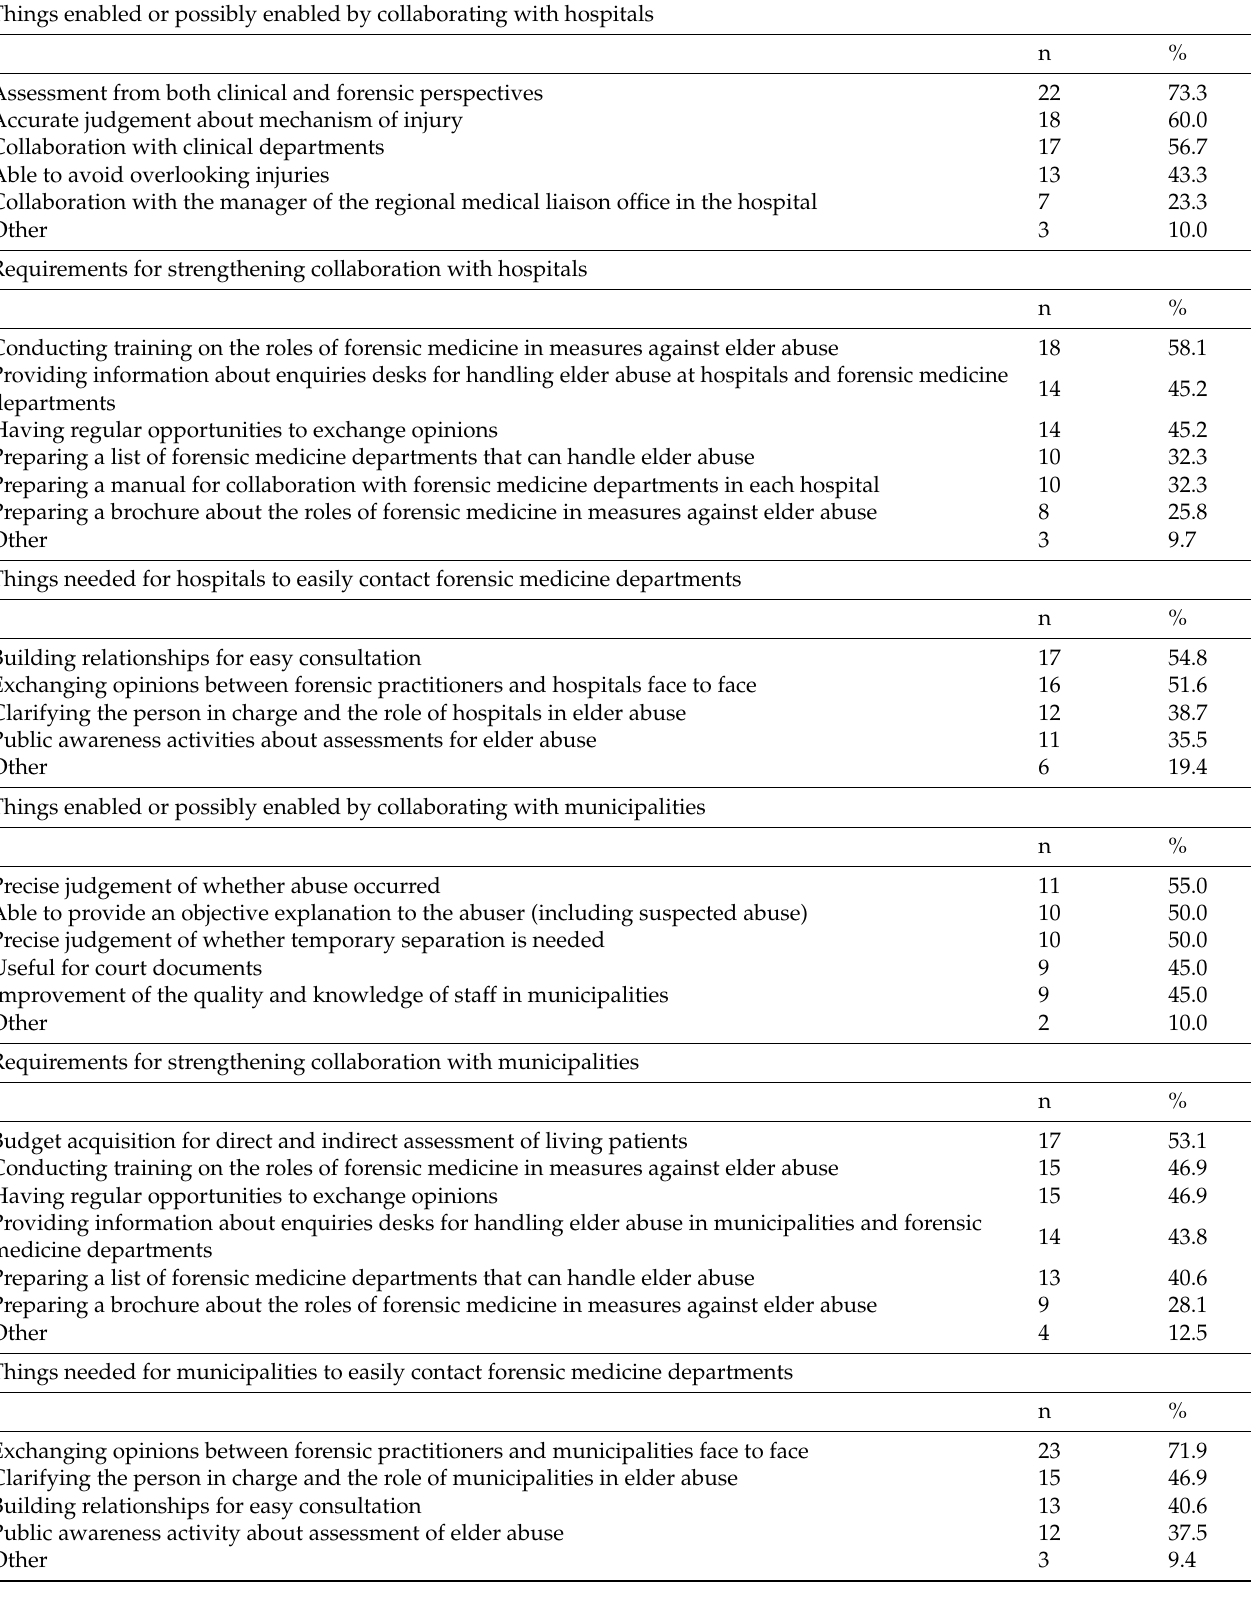
Table 2. Responses regarding collaboration in elder abuse between forensic medicine departments and related